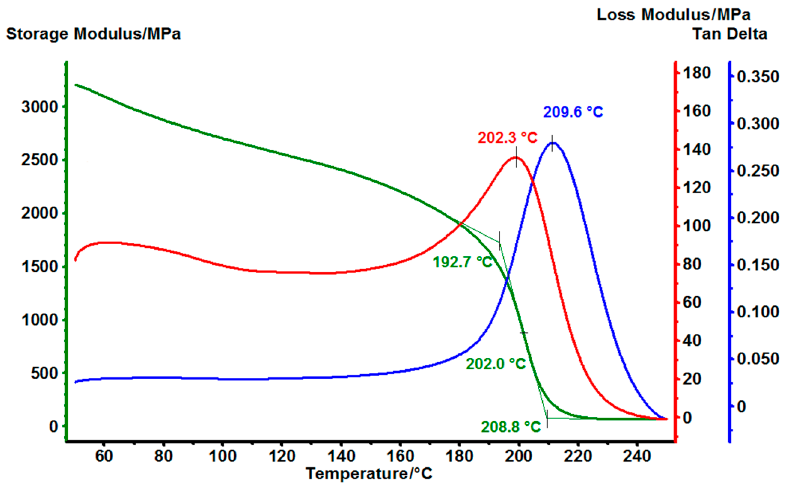
Figure 11. DMA thermogram of EG514.